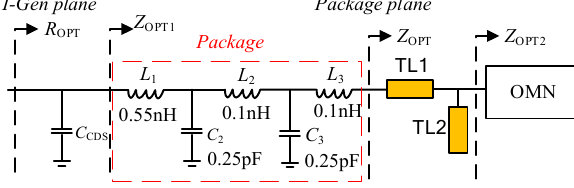
Figure 7. PA branch topology with device parameters.